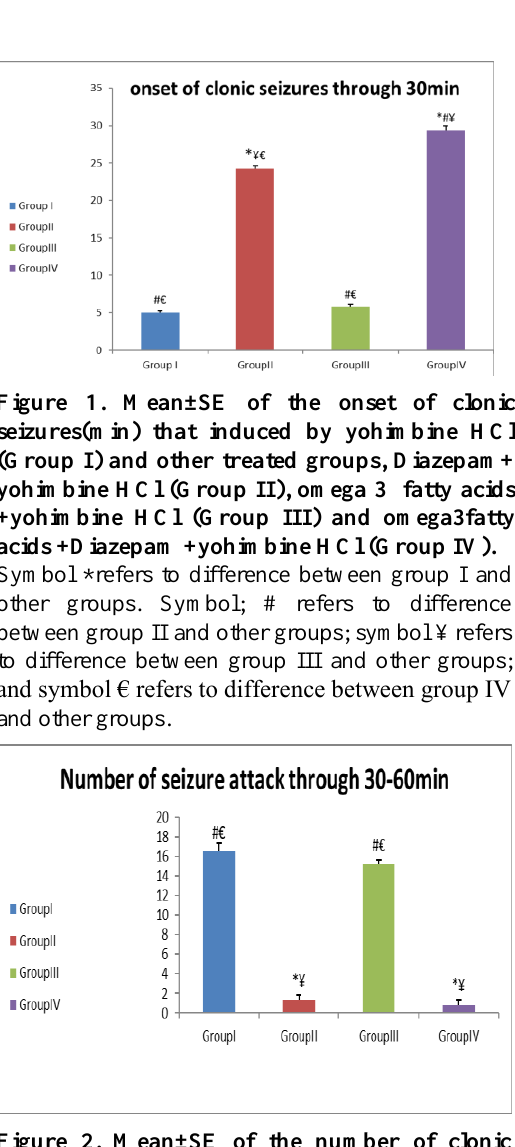
Figure 2. Mean±SE of the number of clonic seizures at 30-60min that induced by yohimbine HCl (Group I) and other treated groups (Diazepam+ yohimbine HCl (Group II), Omega 3 fatty acids +yohimbine HCl (Group III) and omega 3 fatty acids +Diazepam +yohimbine HCl (Group IV). Symbol *refers to difference between group I and other groups. Symbol; # refers to difference between group II and other groups; symbol ¥ refers to difference between group III and other groups; and symbol € refers to difference between group IV and other groups.